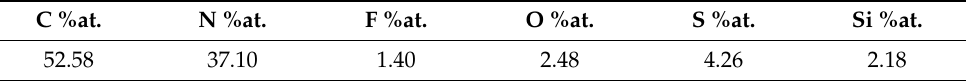
Table 2. Energy-dispersive X-ray spectroscopy analysis results of F,O,S-codoped g-C 3 N 4 . C %at. N %at. F